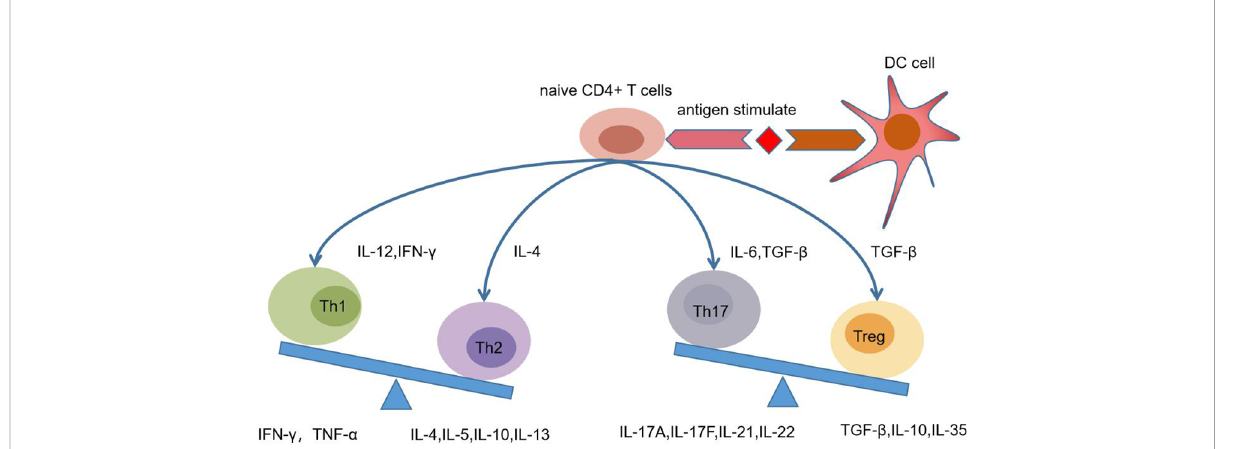
FIGURE 2 Naive CD4 + T cells differentiation in the pregnancy. In different microenvironment, naive CD4 + T cells can differentiate into Th1, Th2, Th17, and Treg under the antigen stimulation which is presented by dendritic cells (DC). For example, IL12 and IFN- g can induce the differentiation of Th1 cells, which secrete cytokines IFN- g and TNF- ɑ . In the Th1/Th2 balance during pregnancy, Th2 is dominant. In the Th17/Treg balance, Treg was